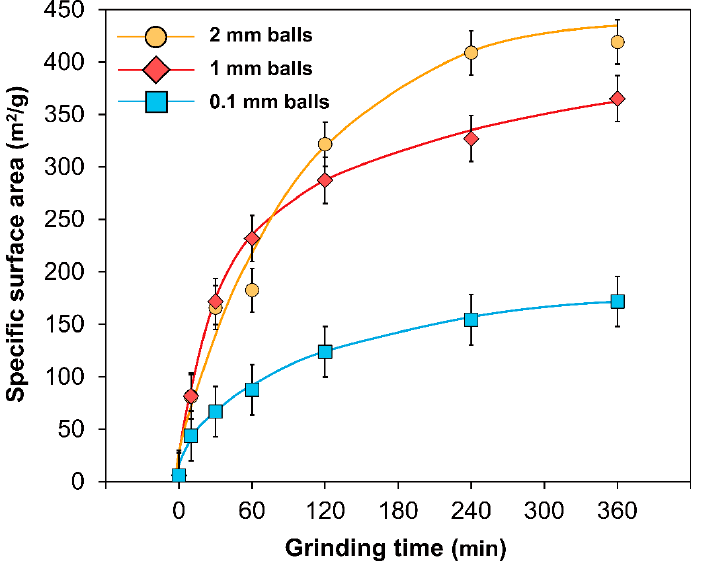
Figure 5. Variation of BET specific surface area of talc upon grinding with varying ball sizes for high-energy ball milling.